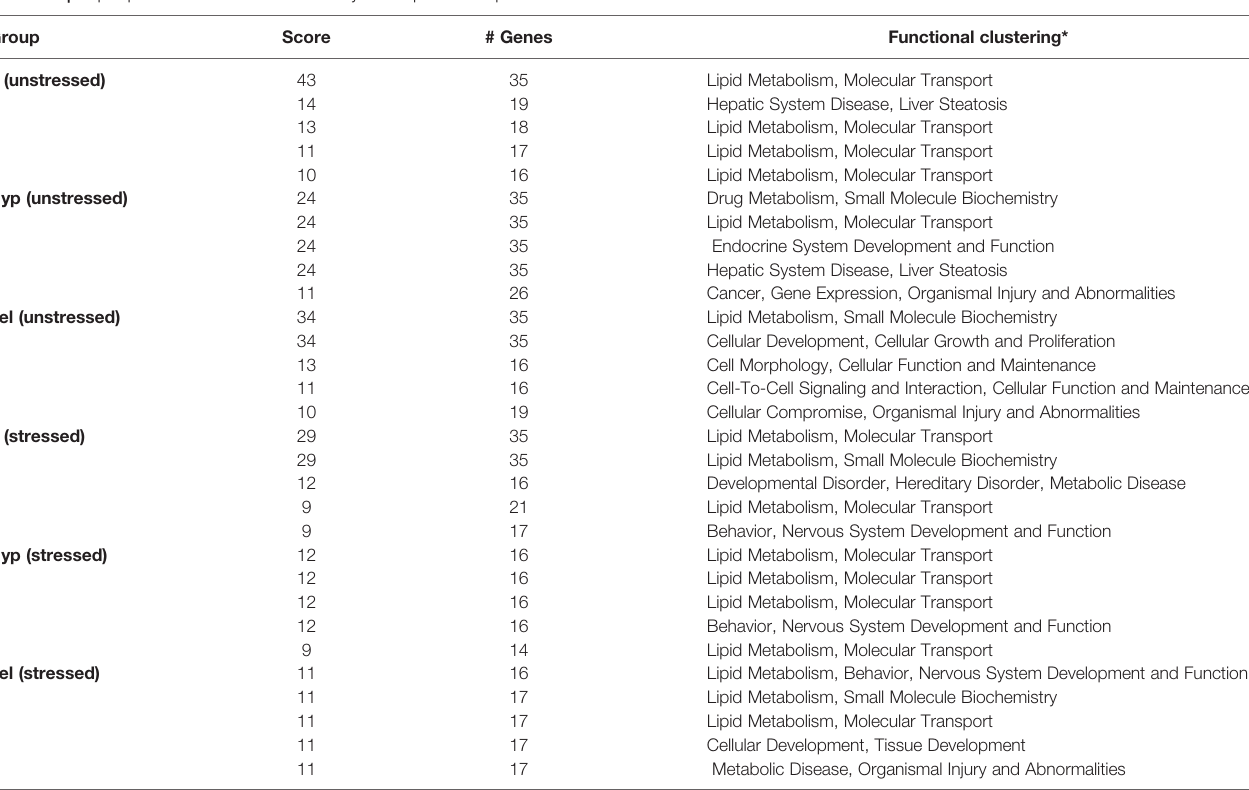
*Gene ontology is associated with Homo sapiens orthologs. L, larval heads; Hyp, hypothalamus; Tel,